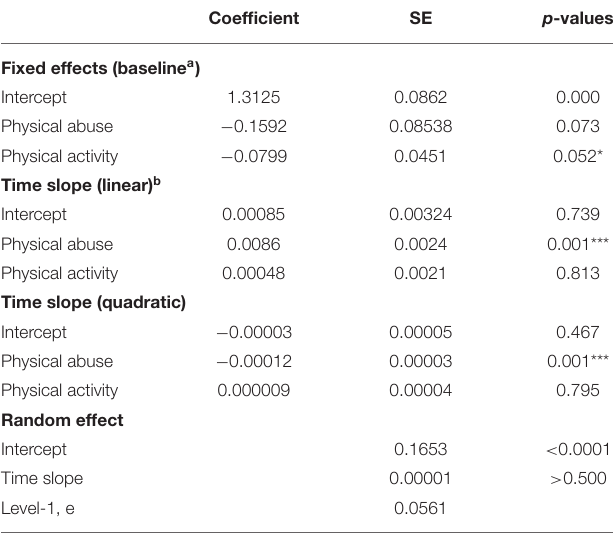
TABLE 2 | Final hierarchical linear model estimates for LF/HF ratio ( N = 34).